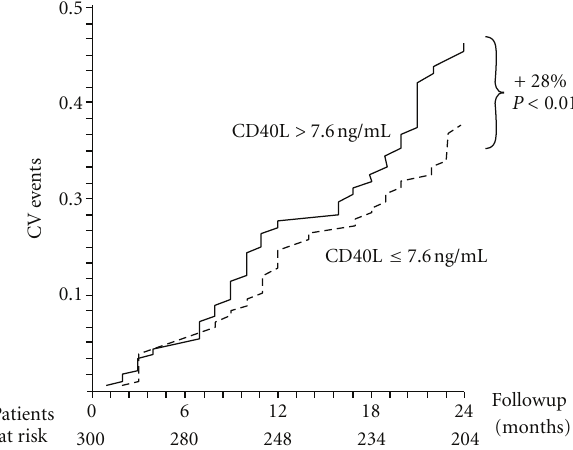
Figure 1: Prognostic value of CD40L in the RISCAVID